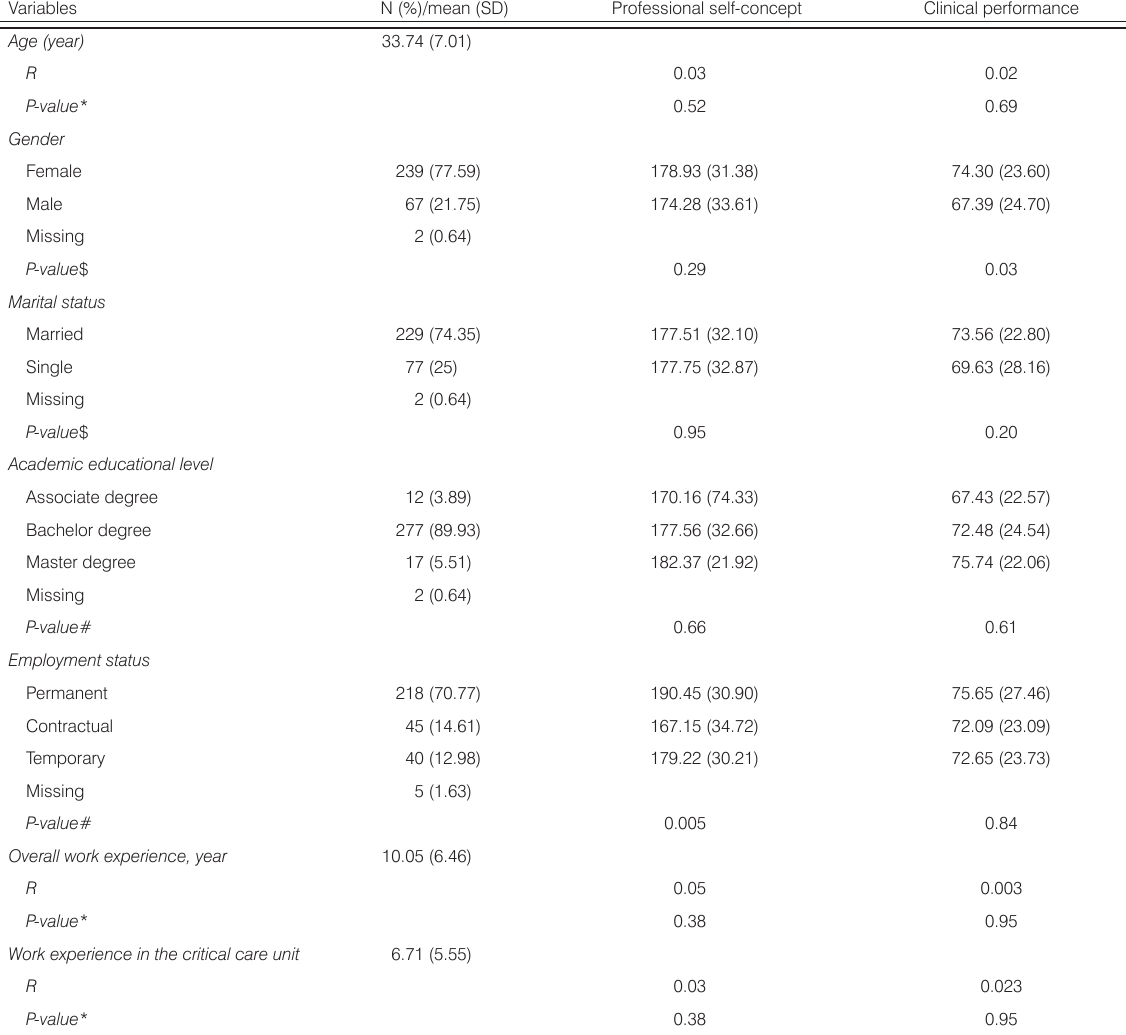
Table 1. Relationship between nurses’ demographic characteristics with professional self-concept and clinical